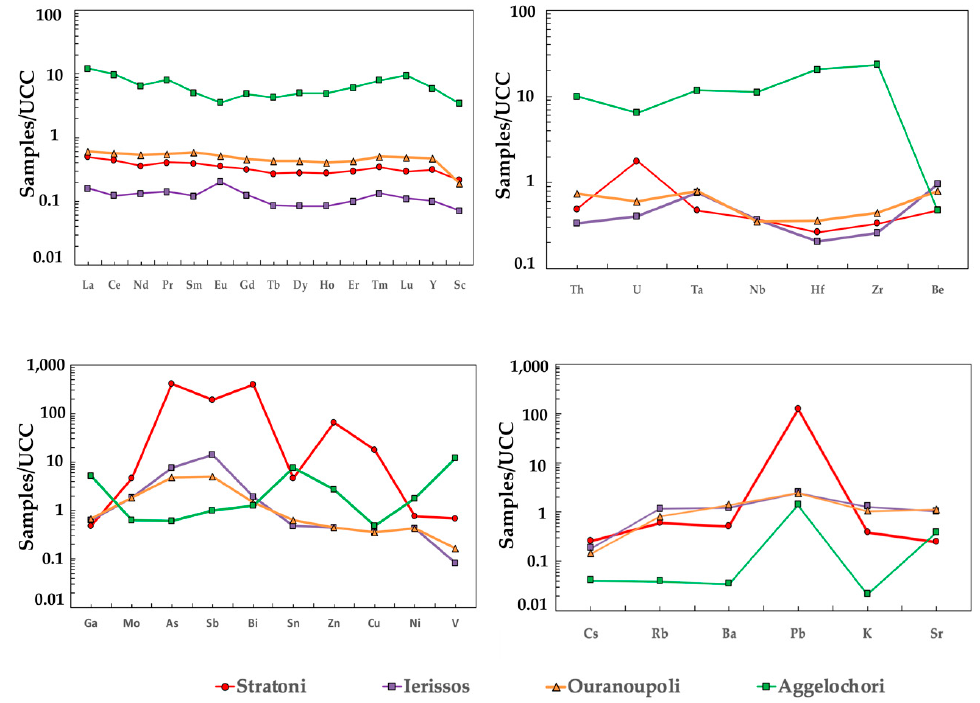
Figure 11. UCC-normalized spidergrams of coastal sands derived from different localities of Chalkidiki peninsula.